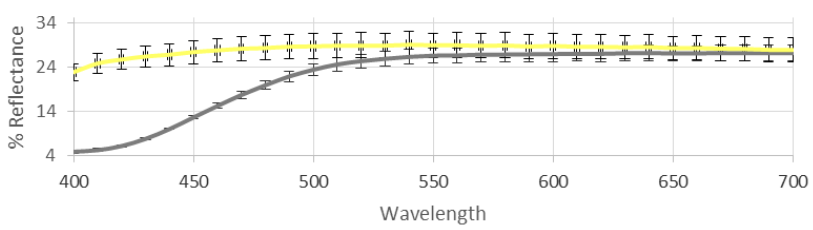
Figure 1. Reflectance curves of hemp essential oil (EO; gray) and its aromatic water (yellow).